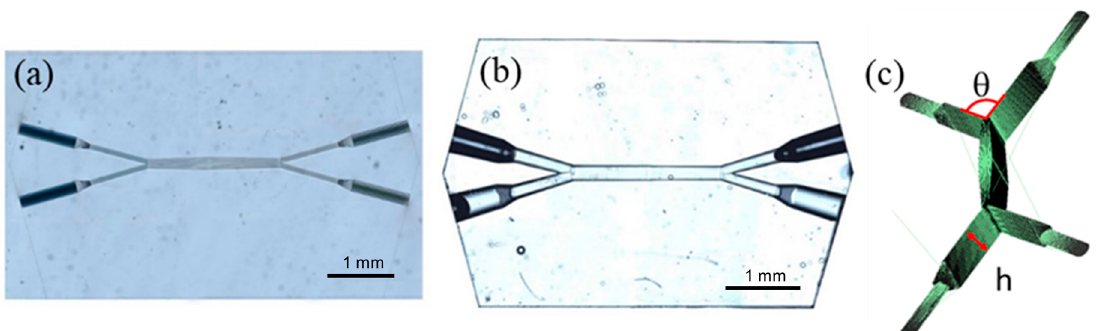
Figure 1. Microfluidic chip geometry; image from optical microscope of the chip after ( a ) femtosecond (fs) laser irradiation and subsequent; ( b ) chemical etching; ( c ) schematic of chip design, where h is the chamber height and θ is the separation angle.